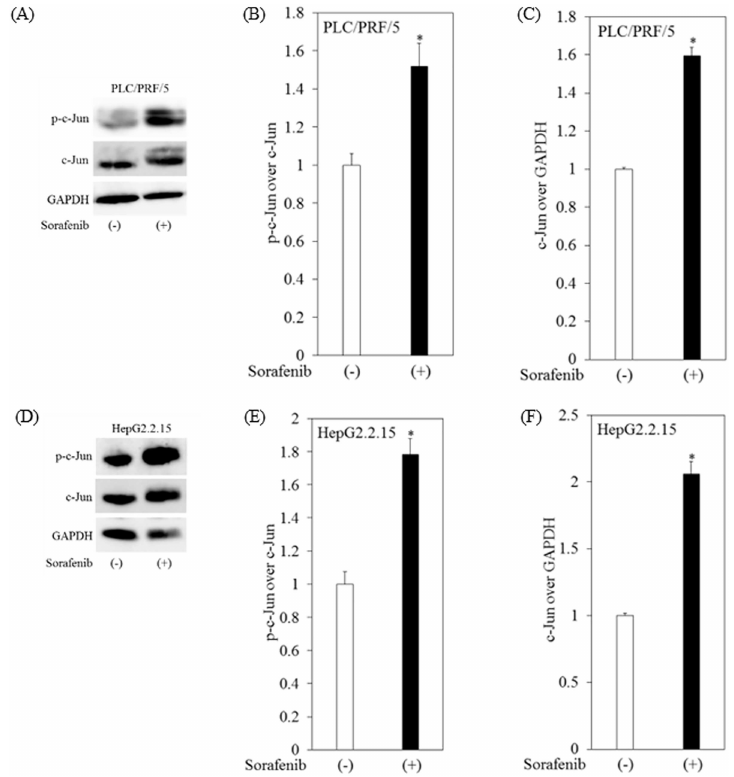
Fig 3. Sorafenib enhances expression and phosphorylation of c-Jun in human hepatoma cell lines. (A)-(C) Western blot analysesof phosphorylated-c-Jun(p-c-Jun), c-Jun and GAPDH expressionin PLC/PRF/ 5 cells treated with or without 10 μ M sorafenib for 12 hours. (D)-(F) Western blot analysesof p-c-Jun, c-Jun and GAPDH expressionin HepG2.2.15 cells treated with or without 10 μ M sorafenibfor 12 hours. (B, C, E, F) Densitometric analyseswere performed using ImageJ software. Data are presentedas mean ± SD of triplicate samples. * p < 0 . 05 comparedto untreatedcontrol.